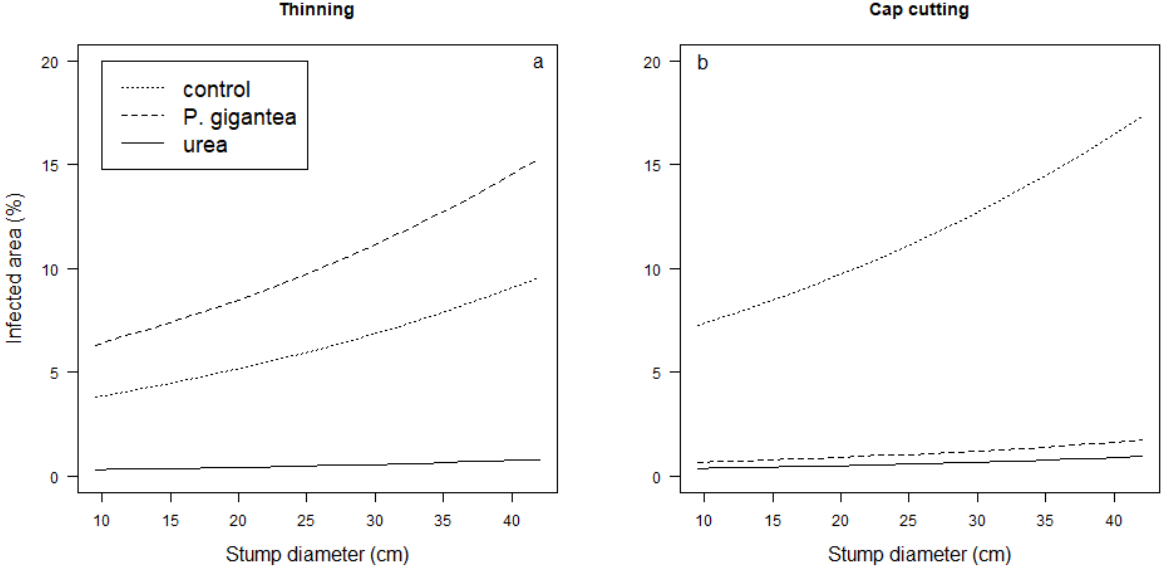
Figure 3. Area covered by Heterobasidion sp. (%) in spruce stumps as a function of stump diameter in different treatments (control, P. gigantea , or urea) after ( a ) thinning and ( b ) cap cutting. Predicted values based on linear mixed models have been used to draw the figure.